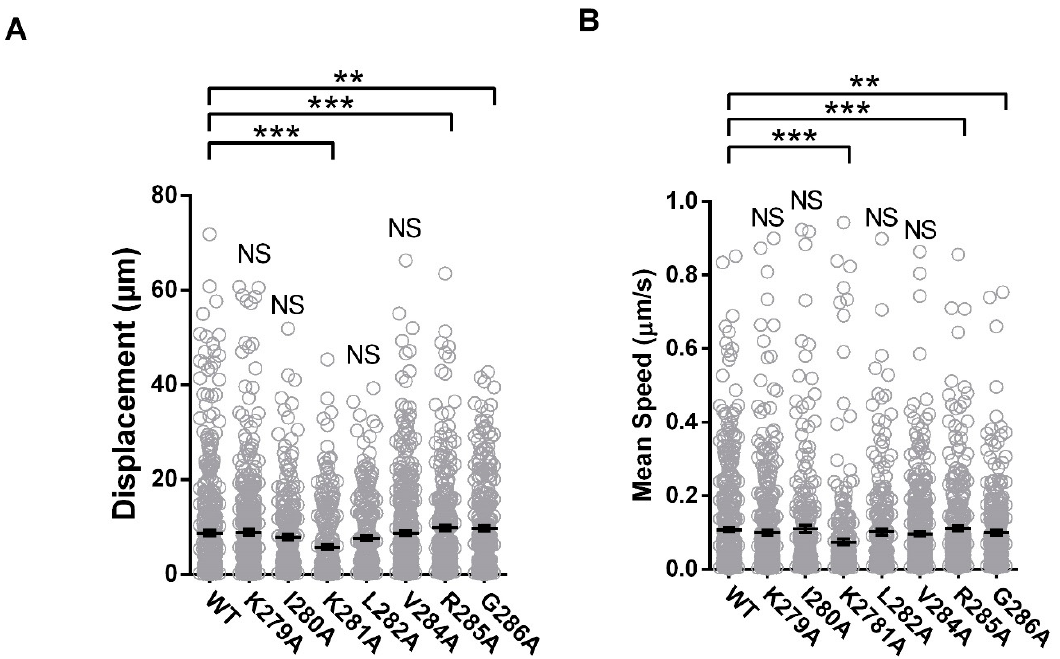
Figure 10. Reduced tra ffi cking of Cx36 vesicles post-alanine mutagenesis. Submembrane vesicular transport of the point mutant constructs was resolved using TIRF microscopy in Neuro-2a